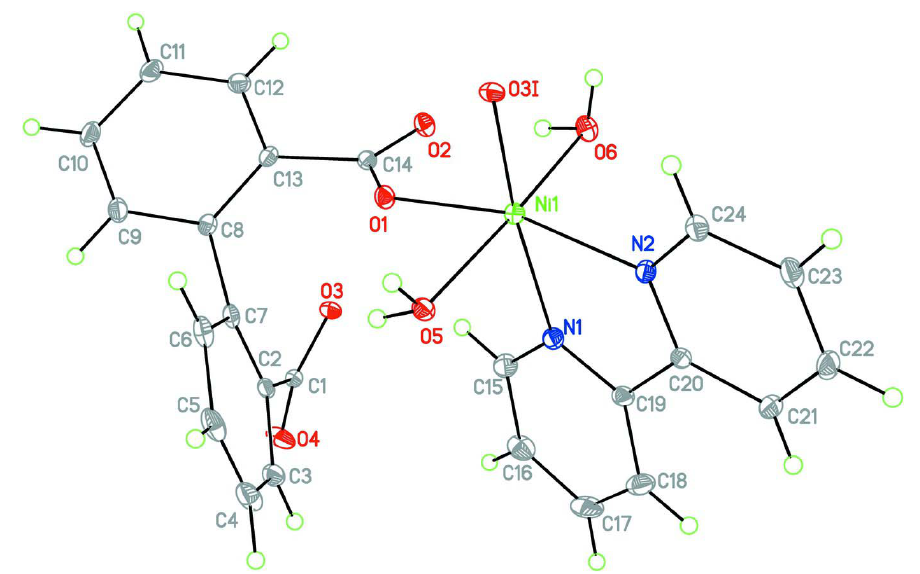
Figure 1 Asymmetric unit of the title compound showing displacement ellipsoids at 30% for non-H atoms.